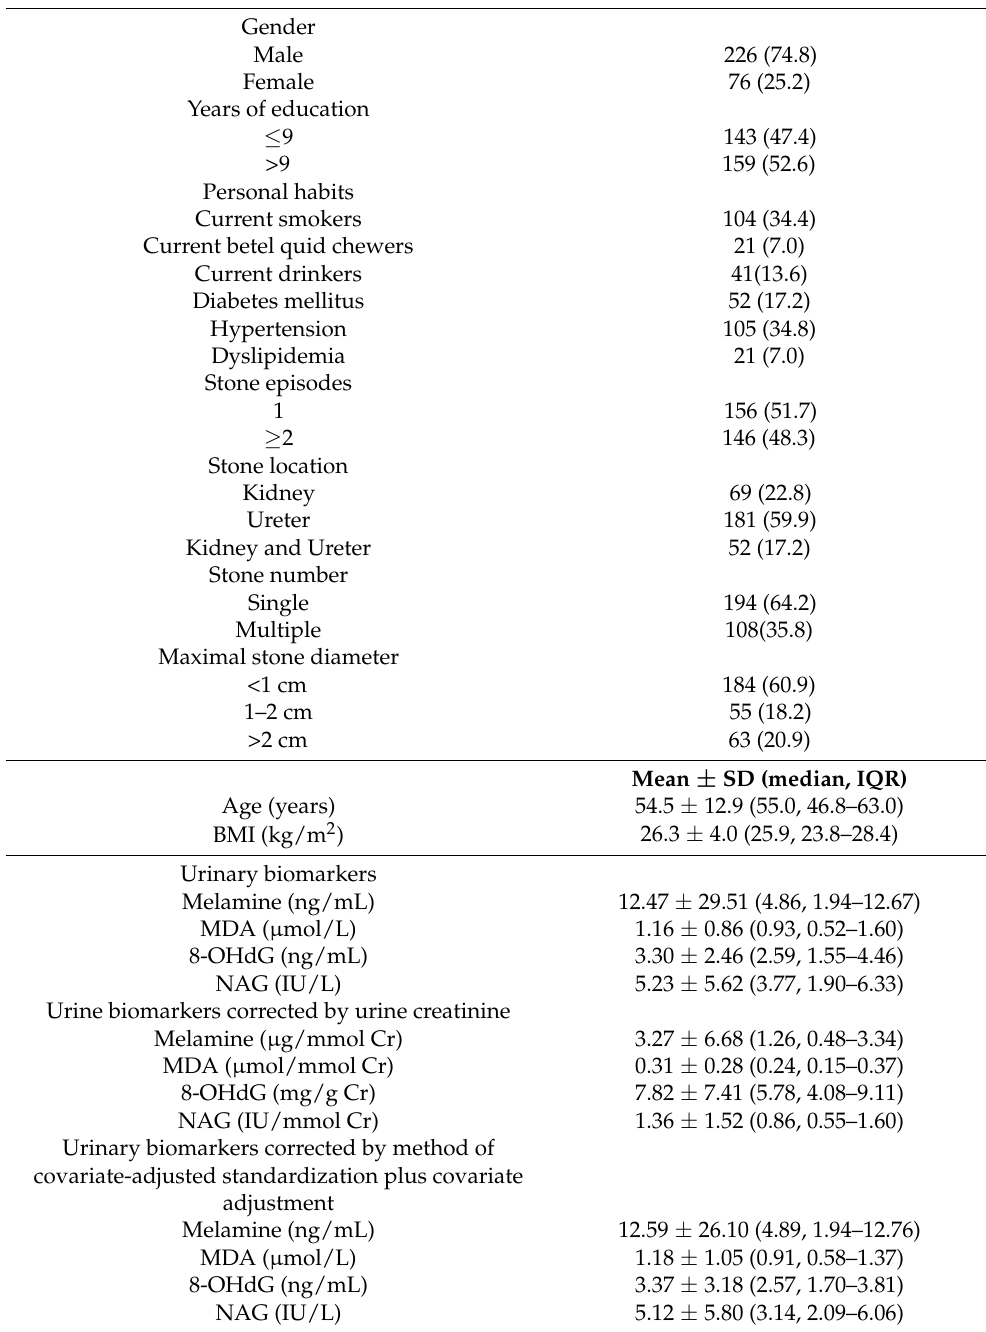
Table 1. Characteristics and laboratory data in 302 calcium urolithiasis